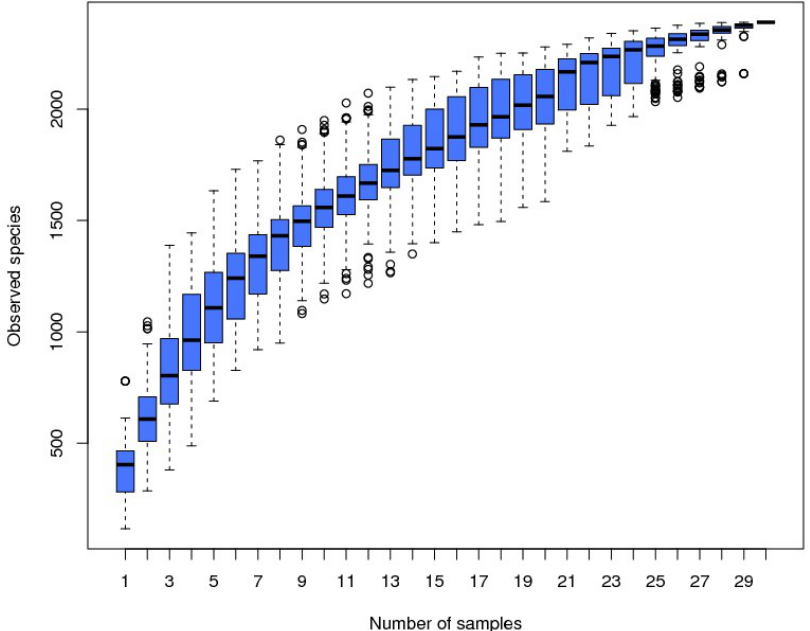
Figure 2. Species accumulation boxplot. The abscissa is the number of black-billed capercaillie sam- ples, and the ordinate is the number of observed species. The species accumulation boxplot reaches a plateau indicating that the number of OTUs in the community does not increase with an expand- ing number of black-billed capercaillie samples.